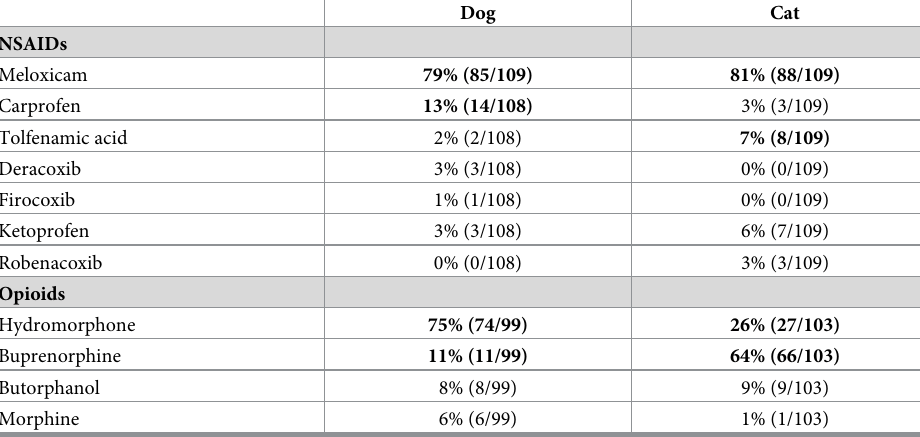
Table 6. English-speaking veterinarians’ preferred NSAID and opioid in dogs and cats for post-surgery analgesia. Dog